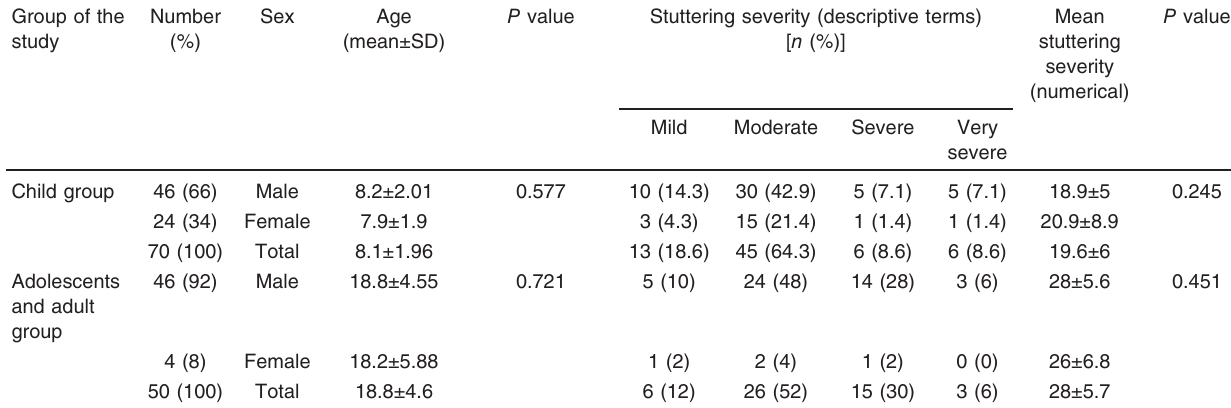
This table shows the distribution of social anxiety disorder among different stuttering severity scores in the two groups studied (groups I and II); +, present; − , absent; SA, social anxiety disorder.